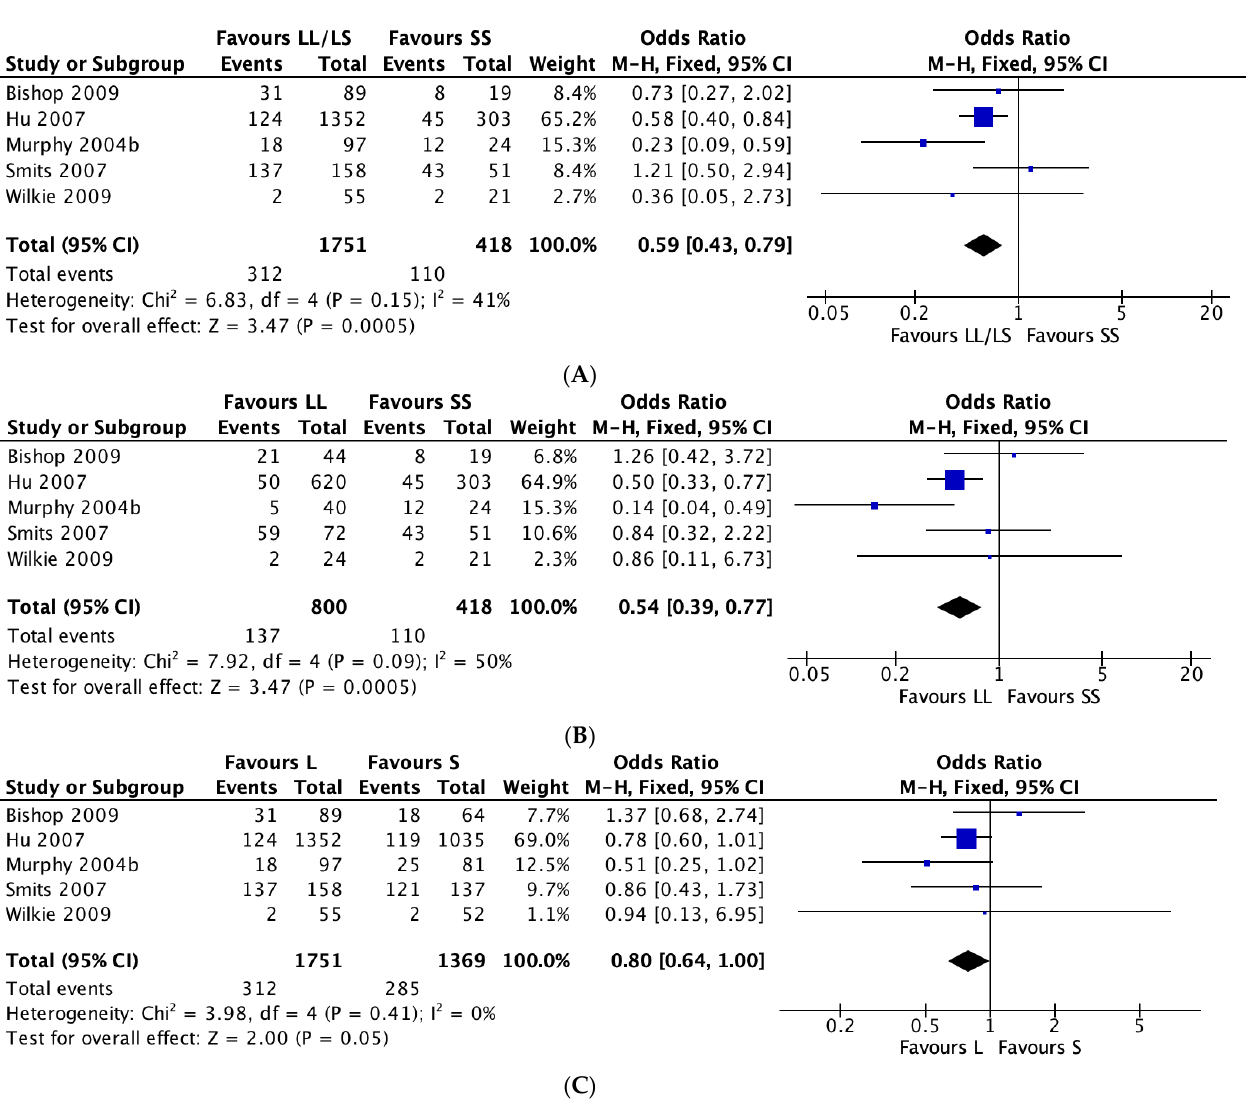
Figure 3. Forest plots of 5-HTTLPR polymorphisms and adverse drug reactions in studies with participants taking SSRIs by genotype comparisons. ( A ) LL/LS vs. SS; ( B ) LL vs. SS; ( C ) L vs. S.